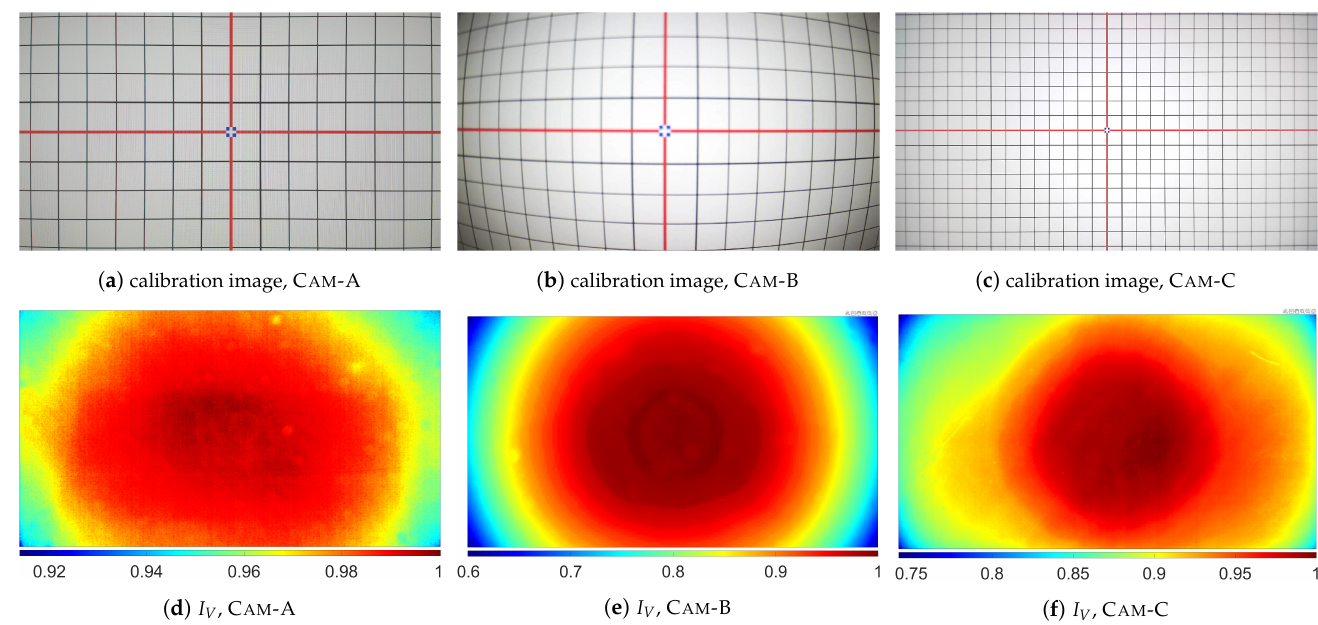
Figure 7. Comparison of acquired calibration images and I V images obtained from the tested cameras.